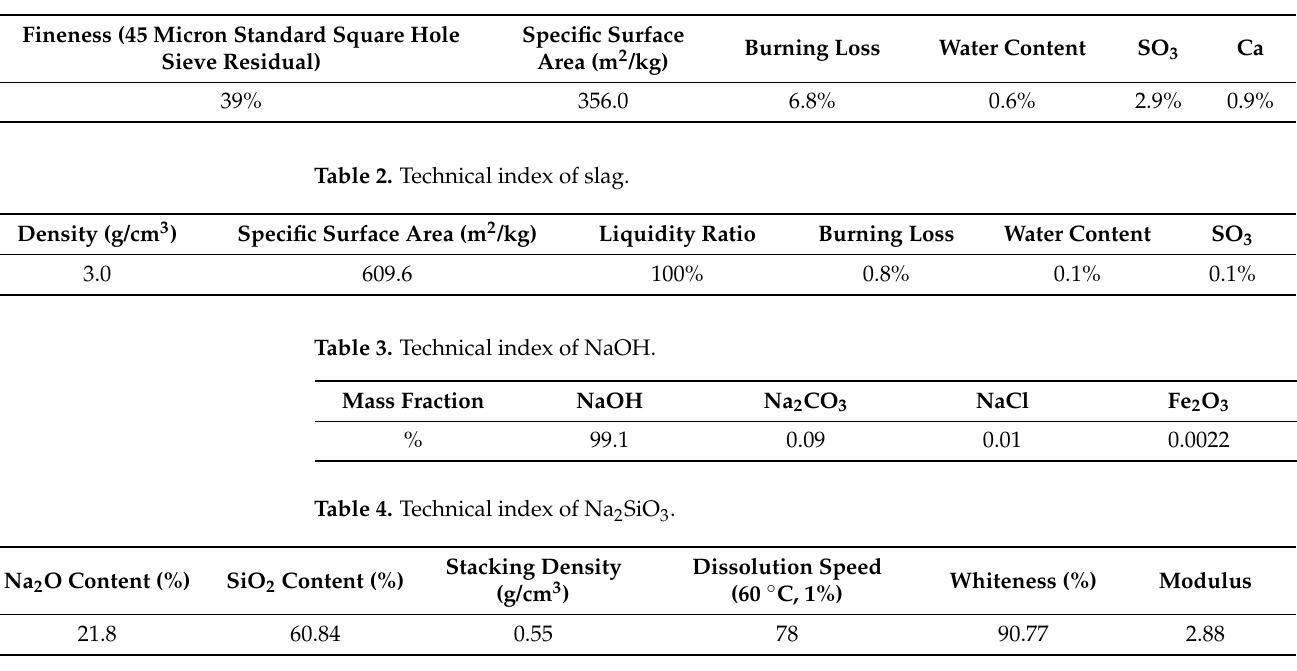
Figure 4. Test materials. Table 1. Technical index of fly ash.